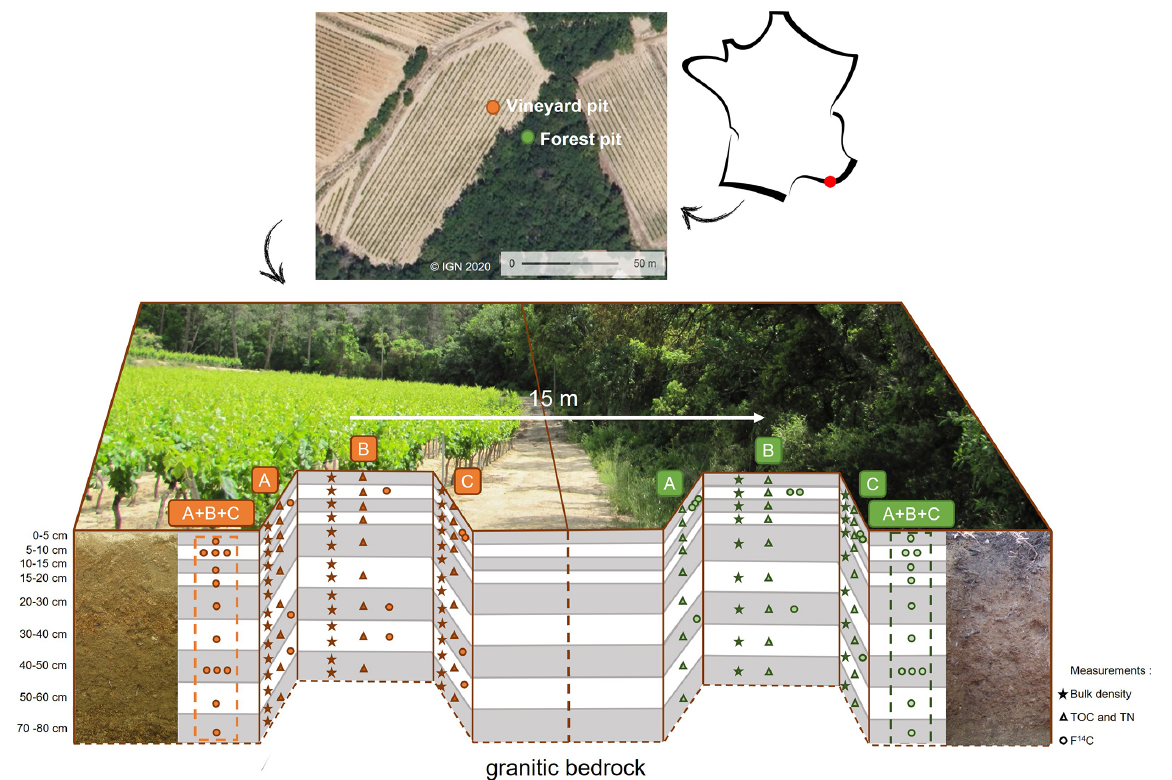
Figure 1. Scheme of the pits and sampling in the Brugassières Arenosol under a Mediterranean climate. On the left is a vineyard site (orange symbols), and on the right is forest site (green symbols). A, B, and C represent the three different sampled sides of each pit. Symbols indicate the sampling and analysis for each sampled layer, where stars indicate the sampling in cylinders for bulk density, triangles indicate the sampling for total organic carbon and total nitrogen (TOC and TN), granulometry, and mineralogy, and circles indicate the sampling for analysis in 14 C. (A + B + C) represent composite samples resulting from the mixture of samples from the three faces at equal